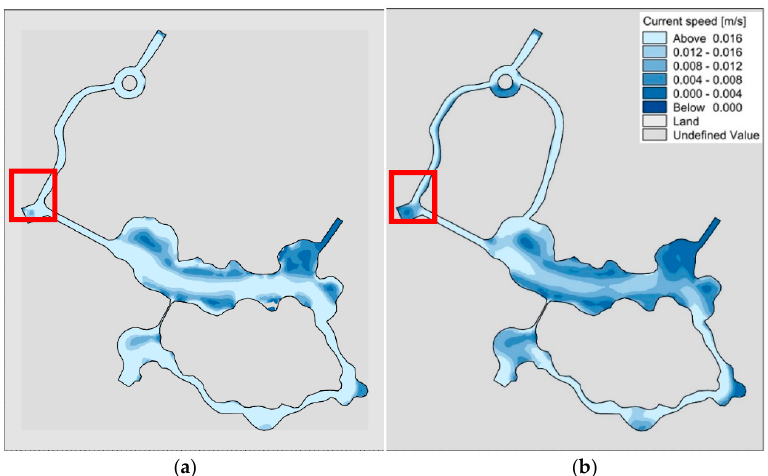
Figure 13. Comparison of the flow field in “unilateral” and “bilateral” rivers after 30 h of pumping. ( a ) “unilateral” river; ( b ) “bilateral” rivers.